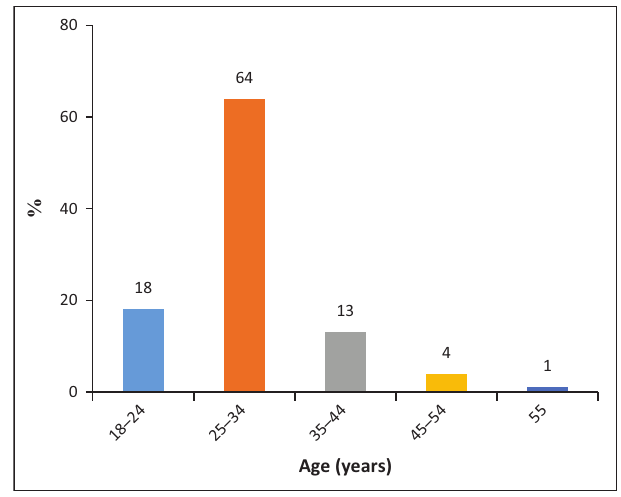
FIGURE 2: Age of participants.